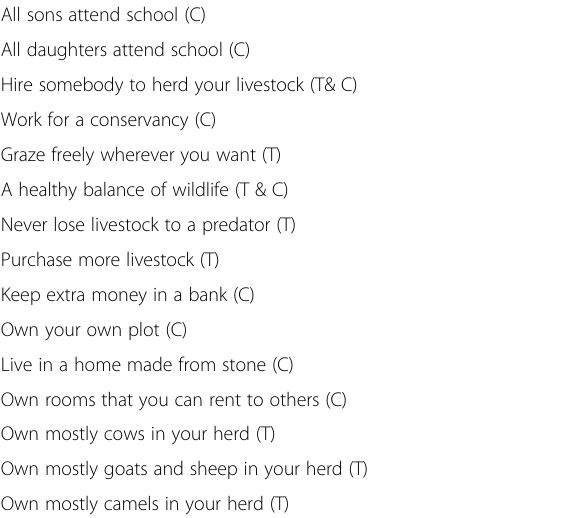
Table 1 List of 15 contemporary (C) and traditional (T) items in paired comparison